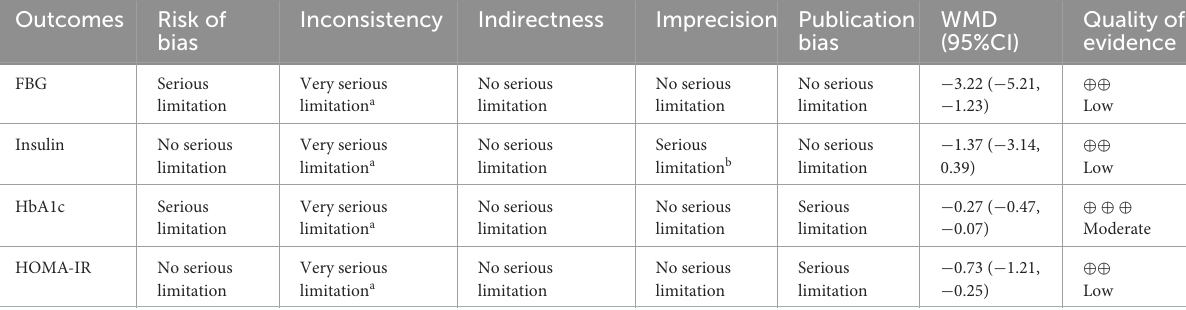
TABLE 4 GRADE profile of L-carnitine for glycemic indices.